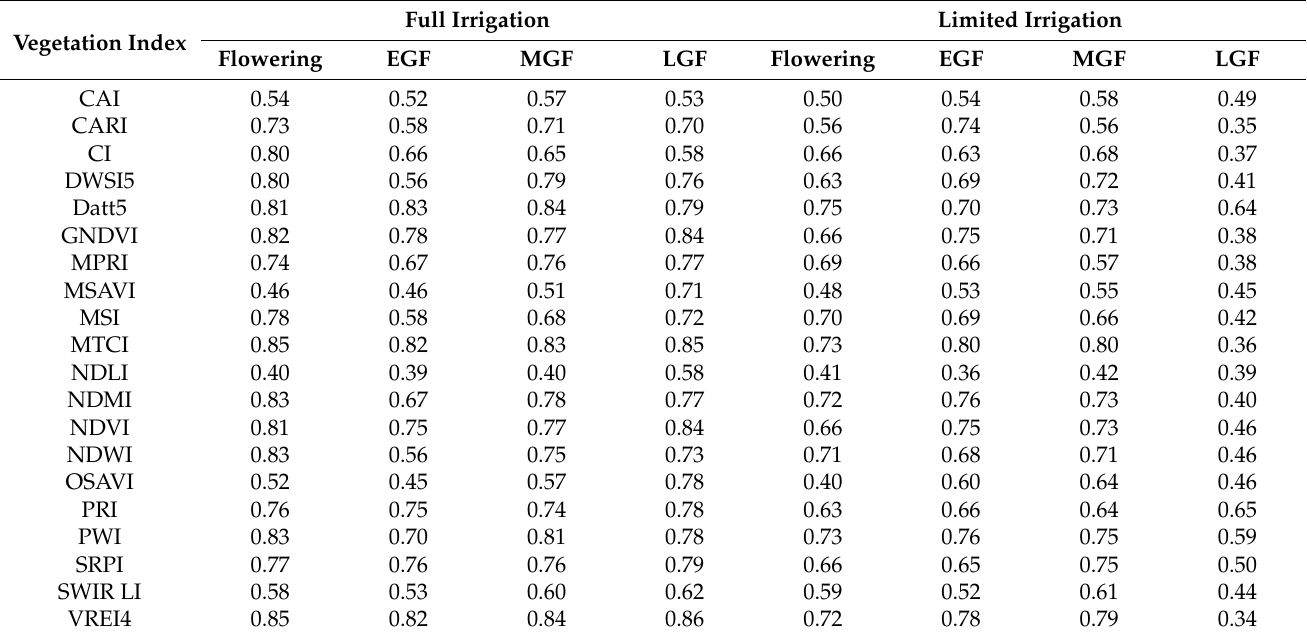
Table A1. Heritability results for vegetation